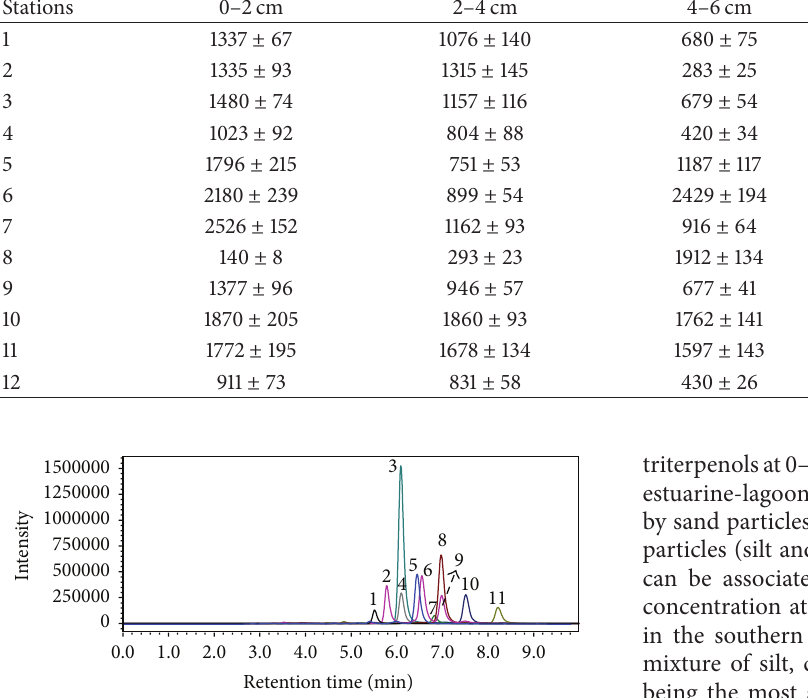
Figure 2: Representative UHPLC-MS/MS chromatogram for the analytes in a standard solution mixture (20ng/mL). Ergosterol (1), epicoprostanol (2), lupeol (3), brassicasterol (4), cholesterol (5), coprostanol (6), campesterol (7), 𝛽 -sitosterol (8), cholestanol (9), stigmasterol (10), and stigmastanol